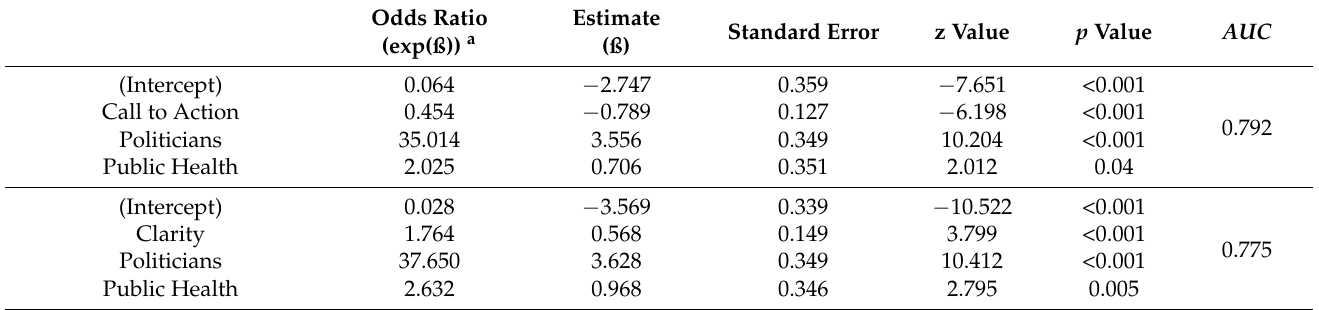
Table 5. Results from six multivariate logistic regression analyses, each with a different guiding principle and tweet source (i.e., government, politician, public health) as predictor variables for the level of tweet